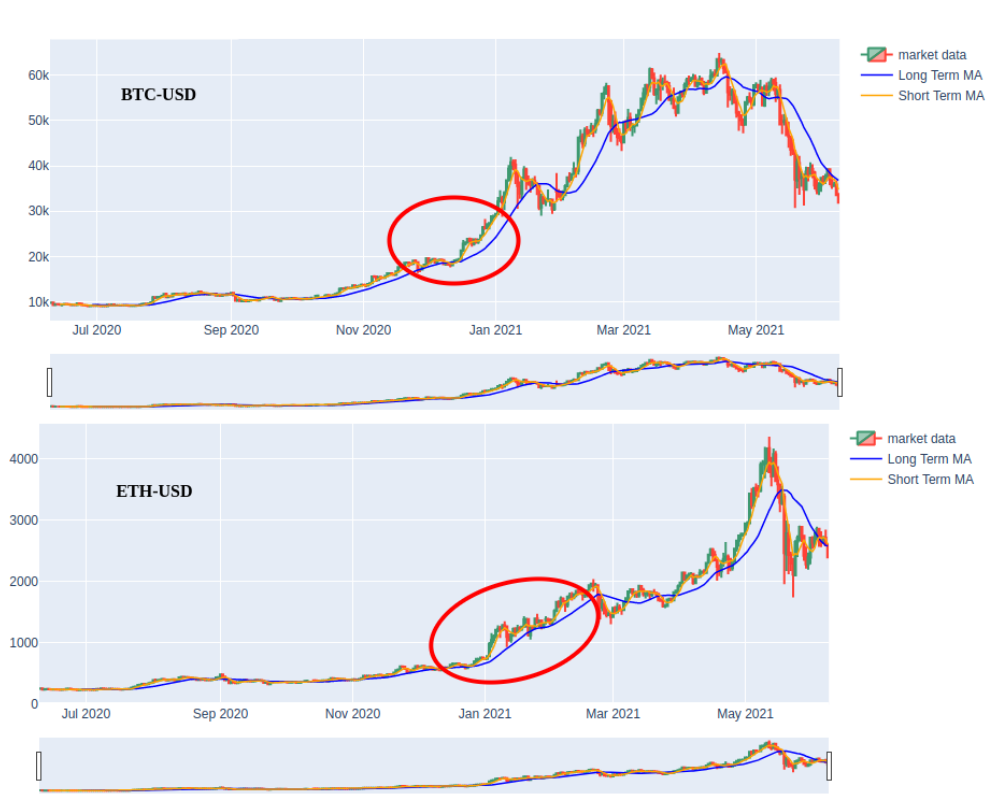
Figure 3. Bitcoin ( upper ) and Ether ( lower ) parabolic moves and their previous lateral phase (red